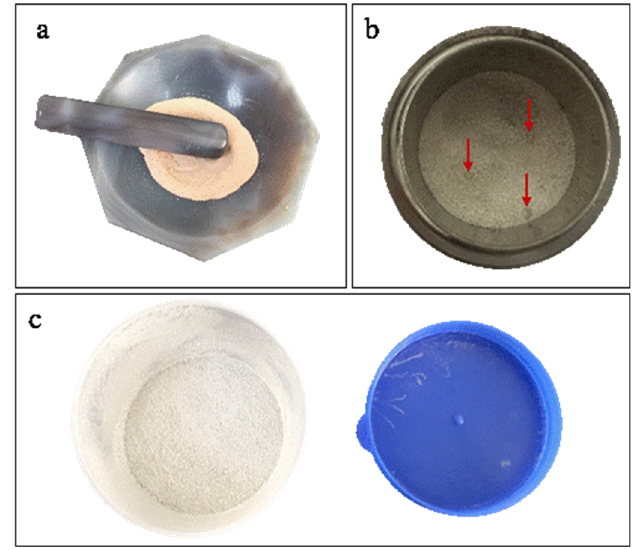
Figure 1. Sample–flux mixtures attained by the ( a ) grinding (GR), ( b ) stirring rod (ST), and ( c ) shaker cup (SH) methods.